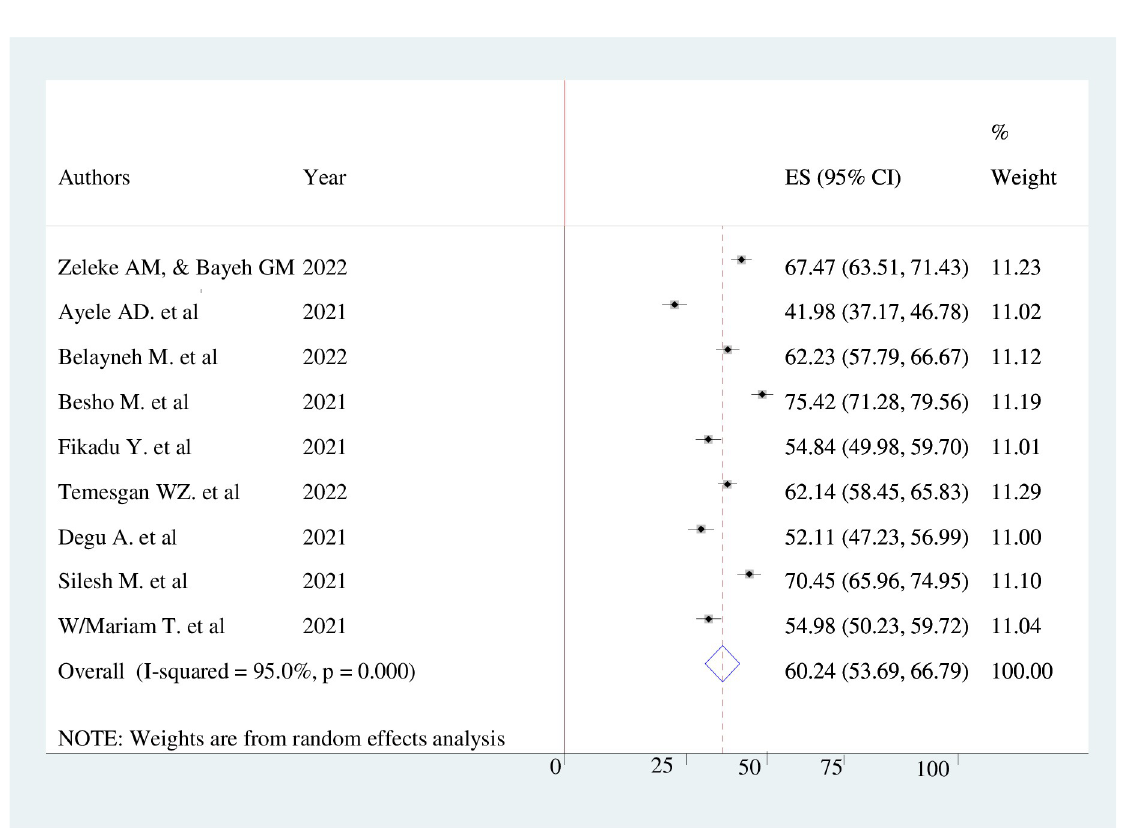
Fig 2. Pooled level of good knowledge of pregnant women’s towards COVID-19 infection